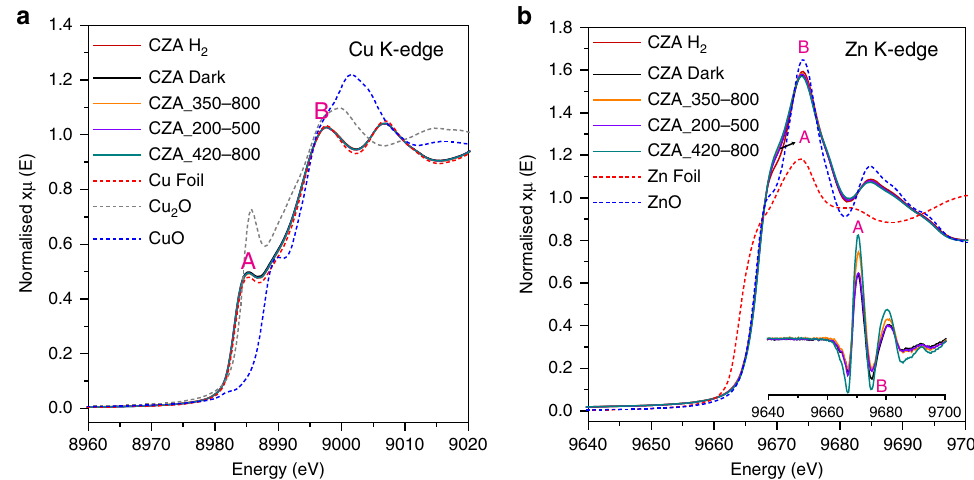
Fig. 5 Local environment of Cu and ZnO following different conditions. a Cu K-edge and b Zn K-edge after reduction and reaction under dark or irradiation with different spectral ranges (350 – 800nm, 200 – 500 nm, 420 – 800nm). Inset: difference spectra obtained by subtracting the spectrum of reduced catalyst (CZA H 2 ). Feature A and B indicate the low-energy shoulder and main absorption peak, respectively, in Cu and Zn